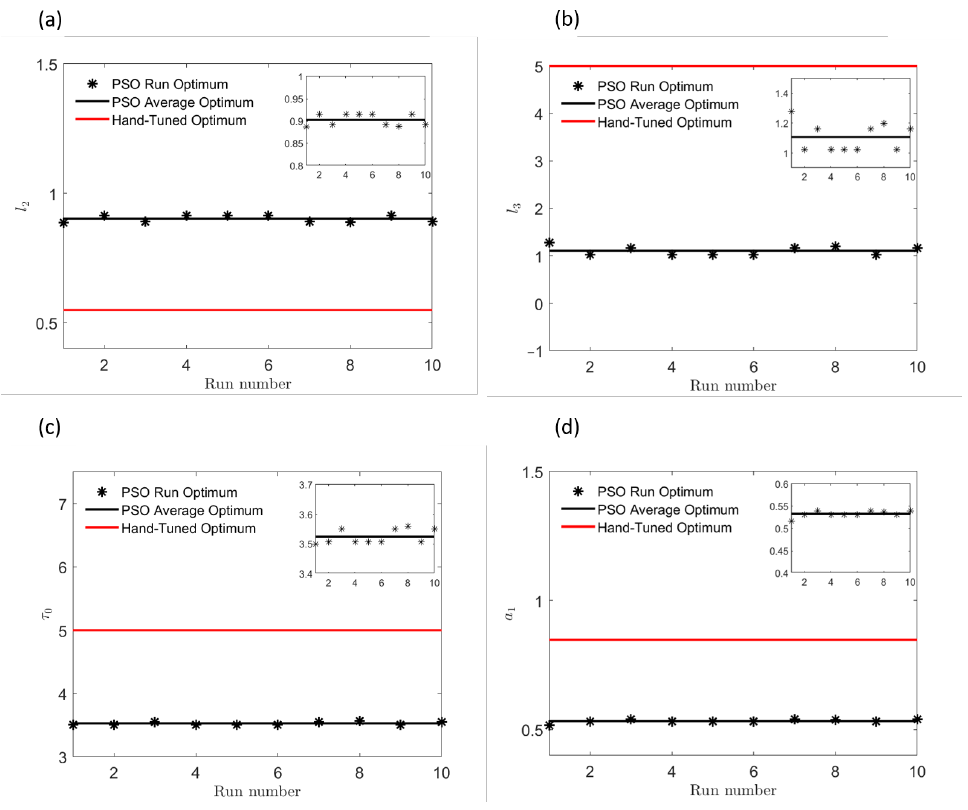
Figure 5. Parameter variance across 10 runs of PSO ( a ) l 2 ( b ) l 3 ( c ) τ 0 ( d ) a 1 .